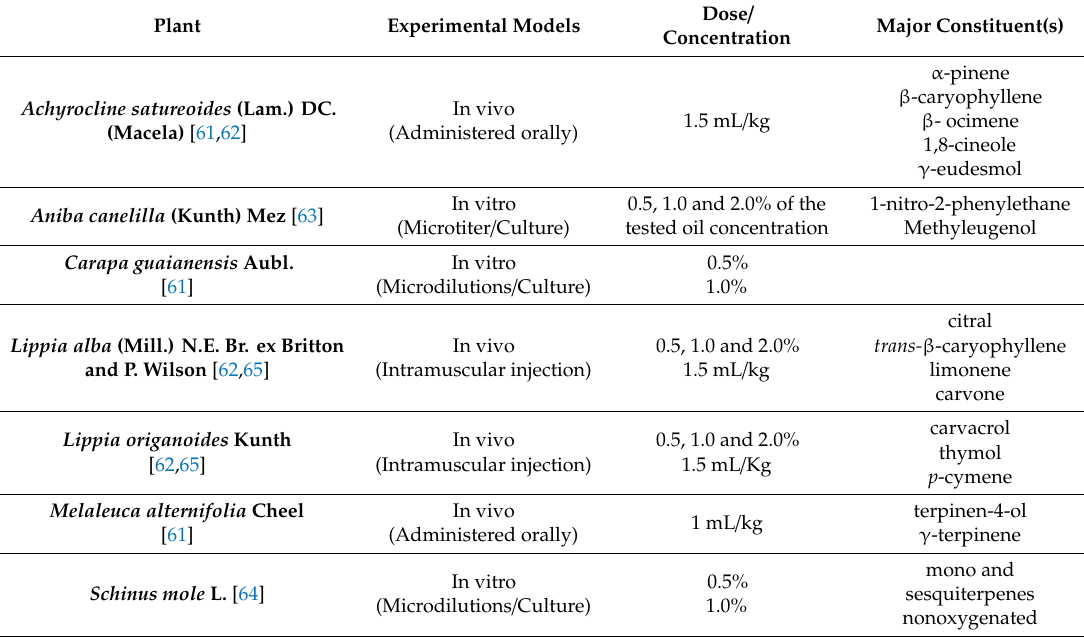
Table 3. Essential oils with trypanocidal activity against T.